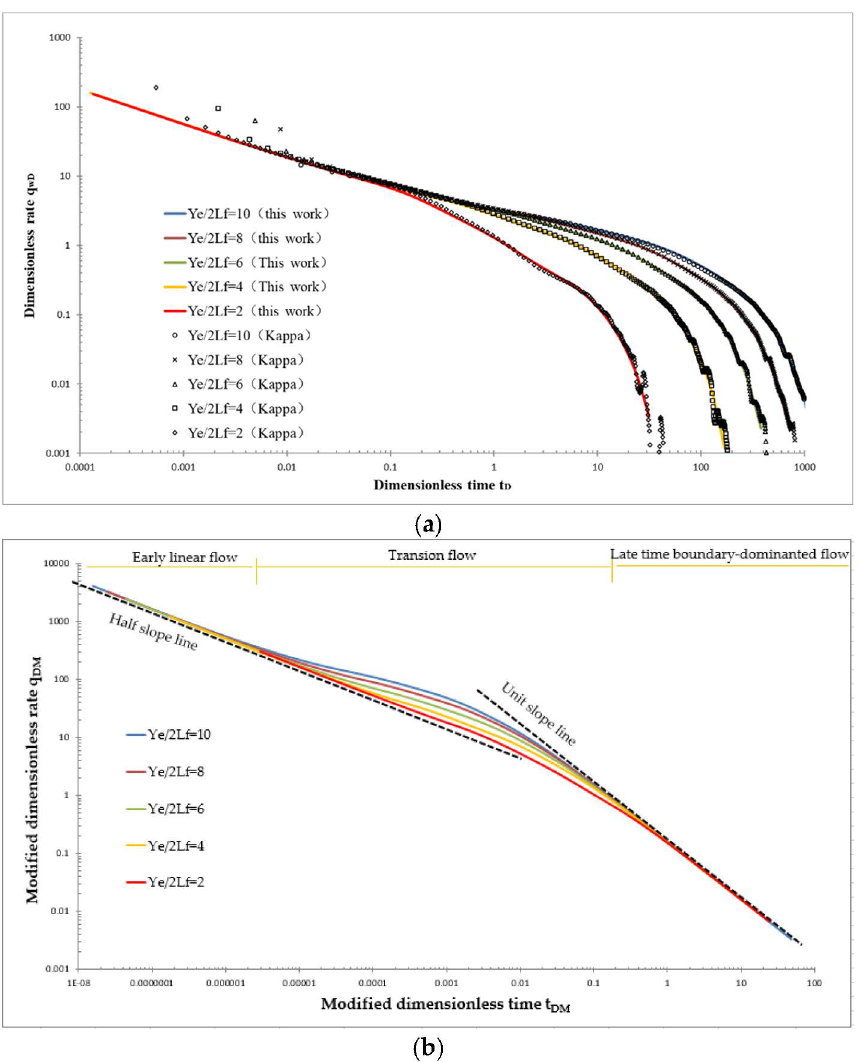
Figure 3. ( a ) Production decline type curves, and ( b ) modified production decline type curves, for fractured horizontal well